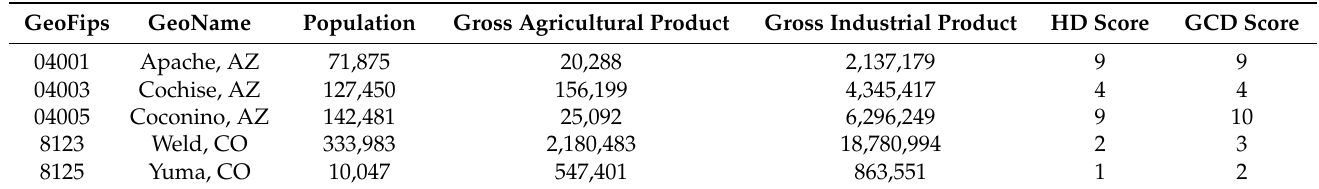
Table 2. Assignment of four major attributes to selected counties in five states. Only the first three and the last two are excerpted